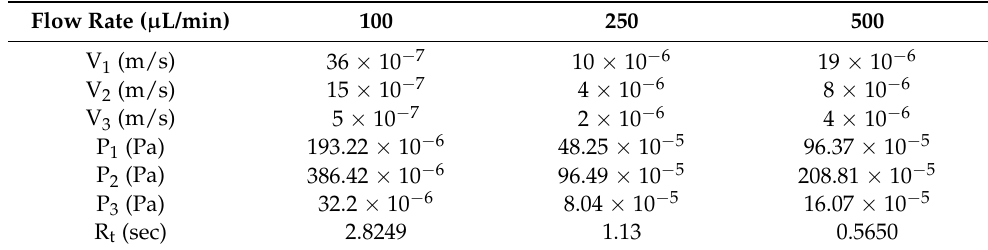
Table 4. Parameters comparison at varying initial flow